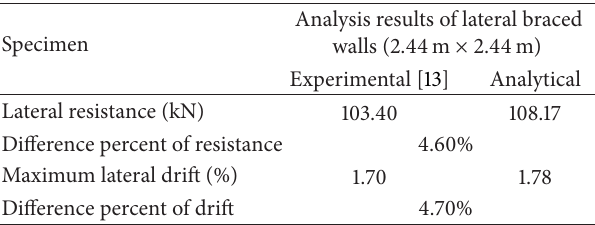
Table 4: Comparison of results, experimental and analytical.